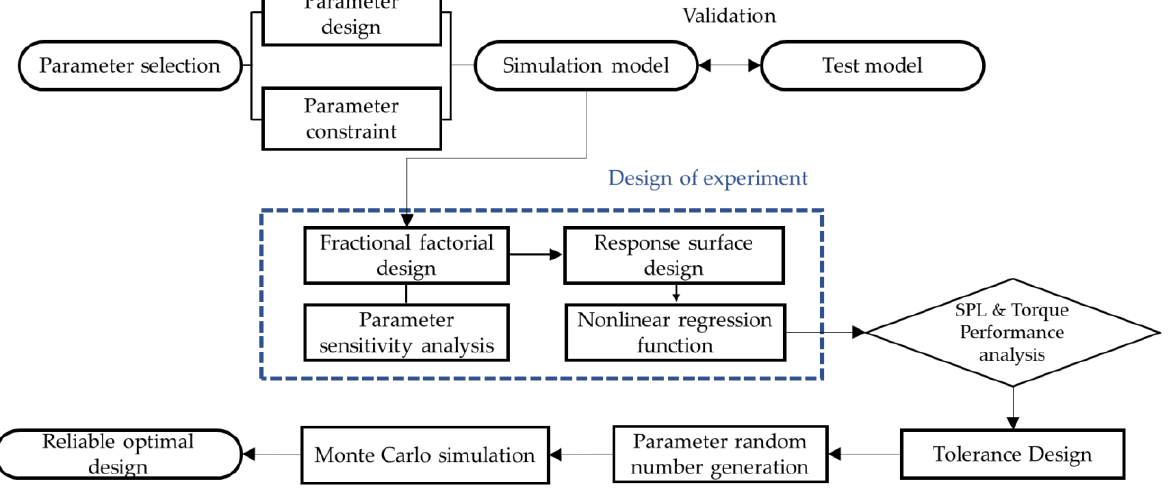
Figure 1. Flowchart of the design of the experiment.